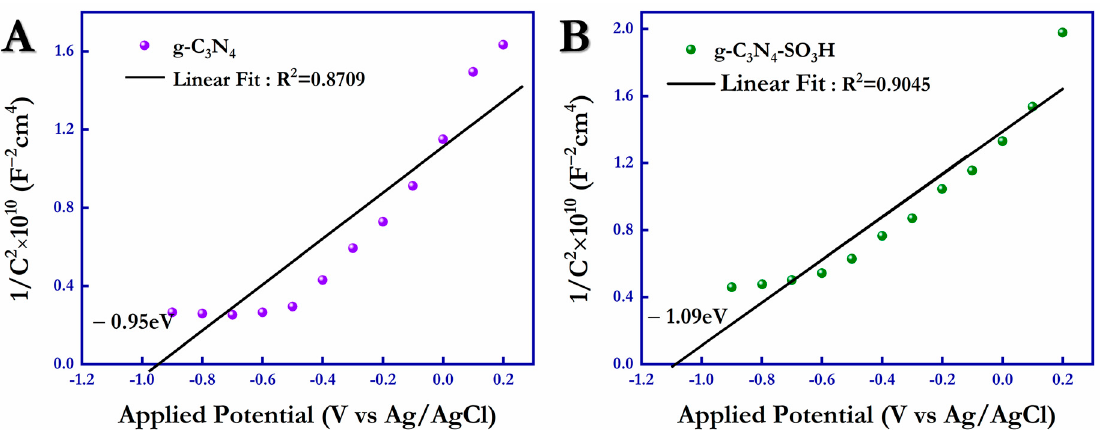
Figure 8. The Mott–Schottky plots for the synthesized g-C 3 N 4 ( A ) and g-C 3 N 4 –SO 3 H ( B ).